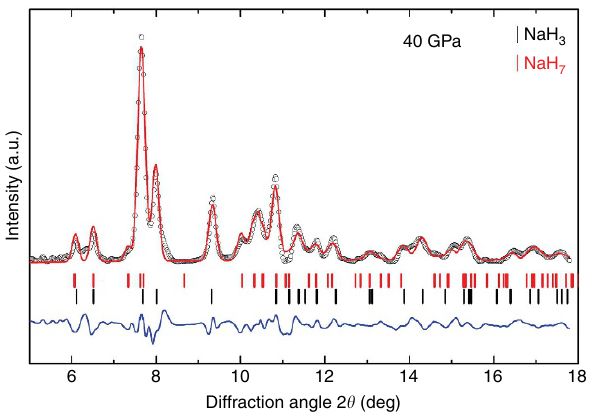
Figure 4 | Le Bail refinement for NaH n at 40GPa. NaH 3 and NaH 7 peaks are marked with black and red vertical lines, respectively. The difference between the data and the fit is shown below (blue